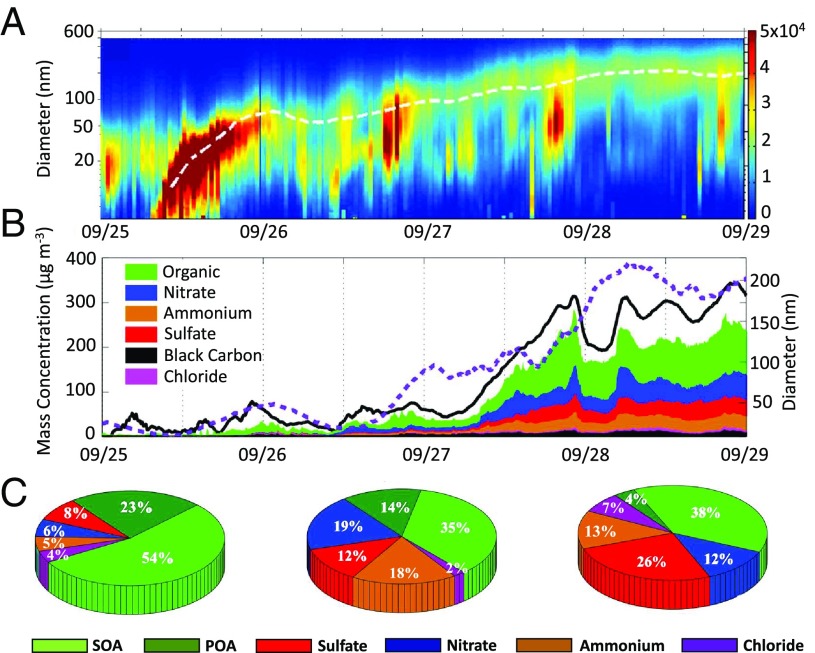
Aerosol nucleation and growth during a pollution episode (September 25–29, 2013) in Beijing. Temporal evolutions of particle number size distribution and mean diameter (white dashed curve) (A); PM2.5 mass concentration (black solid line), mean diameter (purple dashed line), and PM1 (particulate matter smaller than 1.0 μm) chemical composition (B); evolution of particle chemical composition from clean (Left), transition (Middle), to polluted (Right) periods (C). Modified from ref. 9.